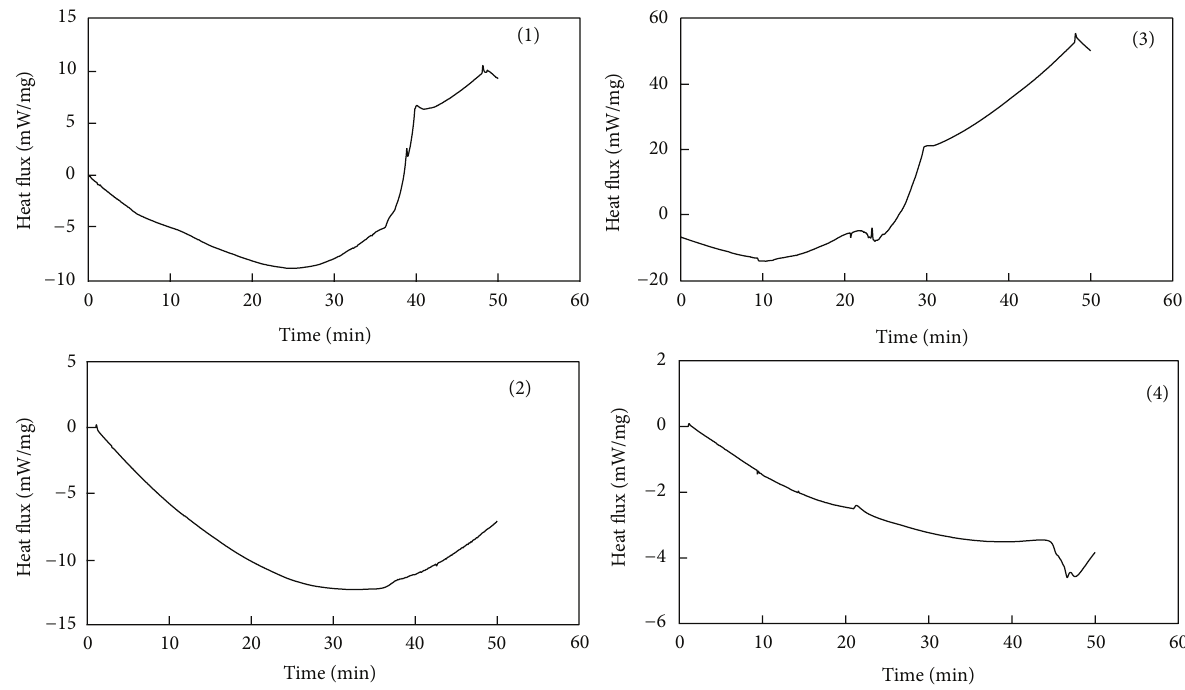
Figure 5: Thermal phenomena of four different types of fireproof foams by differential scanning calorimetry (DSC).